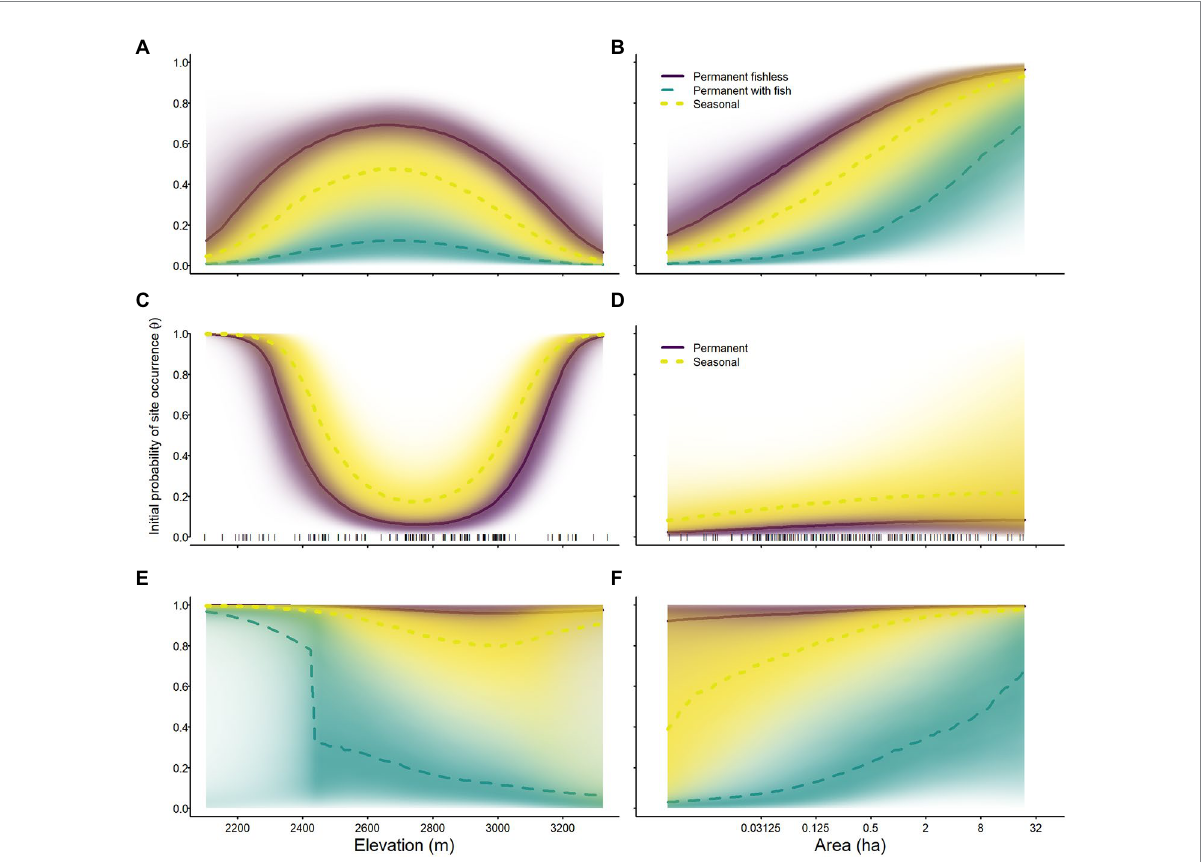
FIGURE 4 Initial probability of occurrence of Sierra Nevada yellow-legged frogs [ Rana sierrae ; (A,B) ], Yosemite toads [ Anaxyrus canorus ; (C,D) ], and sierran treefrogs [ Pseudacris sierra ; (E,F) ] in relation to elevation (A,C,E) , site area [ (B,D,F) ; plotted on a log scale], and site type (indigo shading and solid line = permanent [and fishless for panels (A–D) ]; aqua shading and dashed line = permanent with fish; gold shading and dotted line = seasonal) in Yosemite National Park, California, United States, 2007. Lines represent posterior modes and shading intensity represents the posterior probability